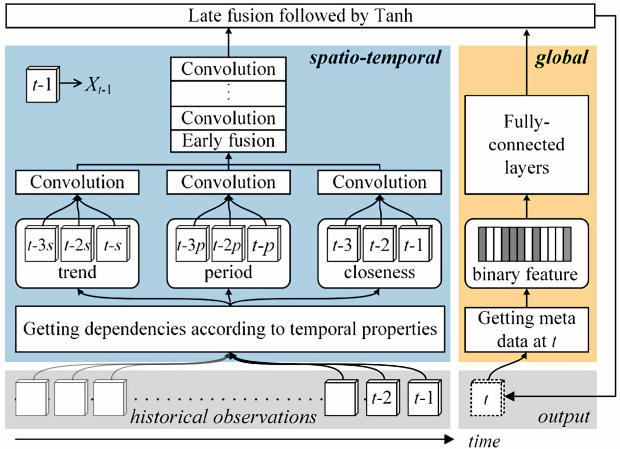
Figure 8. Architecture of DNN-based prediction model for spatial-temporal data (DeepST) [41].